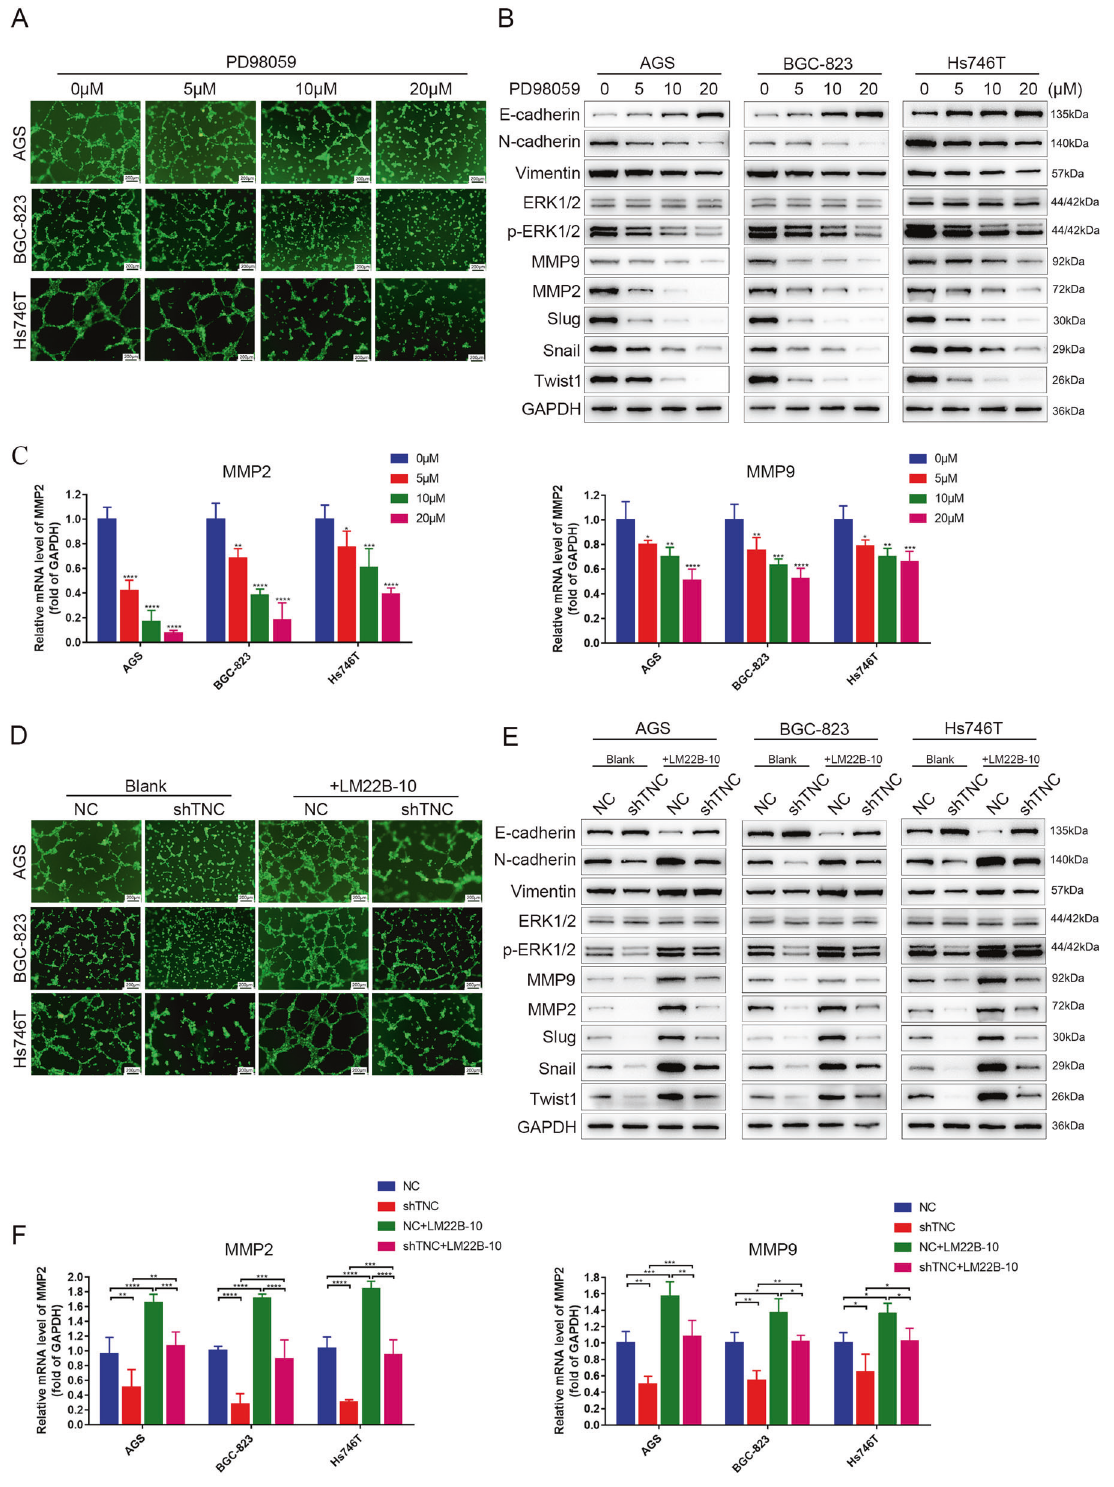
Fig. 5 Knockdown of TNC inhibited VM through ERK-mediated EMT. A VM formation was inhibited in AGS, BGC-823 and Hs746T cells after exposure to the ERK inhibitor PD98059. B Western blot of ERK and EMT markers expression in AGS, BGC-823 and Hs746T cells after exposure to PD98059. C qPCR analysis of MMP2/9 in AGS, BGC-823 and Hs746T cells after exposure to PD98059. D VM formation of AGS, BGC-823 and Hs746T cells transfected with shTNC were increased upon treatment with the ERK activator LM22B-10. E Western blot of ERK and EMT markers expression in AGS, Hs746T and BGC-823 cells transfected with shTNC and treated with LM22B-10. F qPCR analysis of MMP2/9 in AGS, BGC-823 and Hs746T cells transfected with siTNC and treated with LM22B-10. Results were shown as mean ± SD of three independent experiments; each experiment was performed in triplicate. * P < 0.05; ** P < 0.01; *** P < 0.001; **** P <